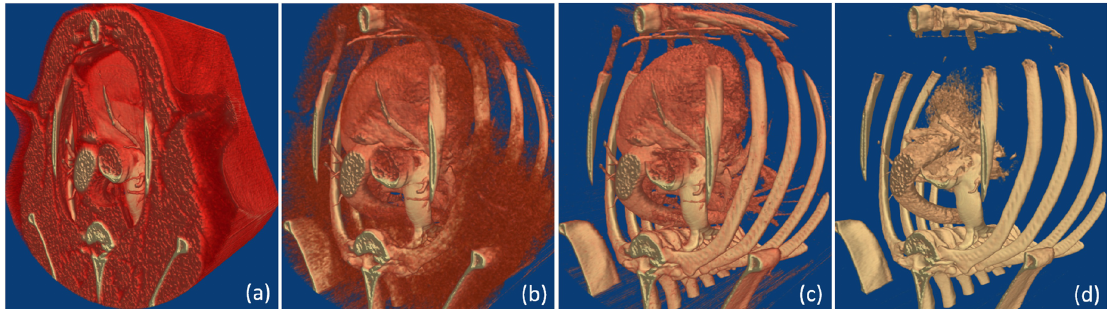
Figure 2. Rendered 3D medical images with WebGL-based raycasting algorithms showing different organs: ( a ) Image of the whole human heart with surrounding tissue, ( b ) heart without surrounding tissue but with a part of the bones inside the muscles, ( c ) thorax with the bone structure, and ( d ) only the bone structures. Source: